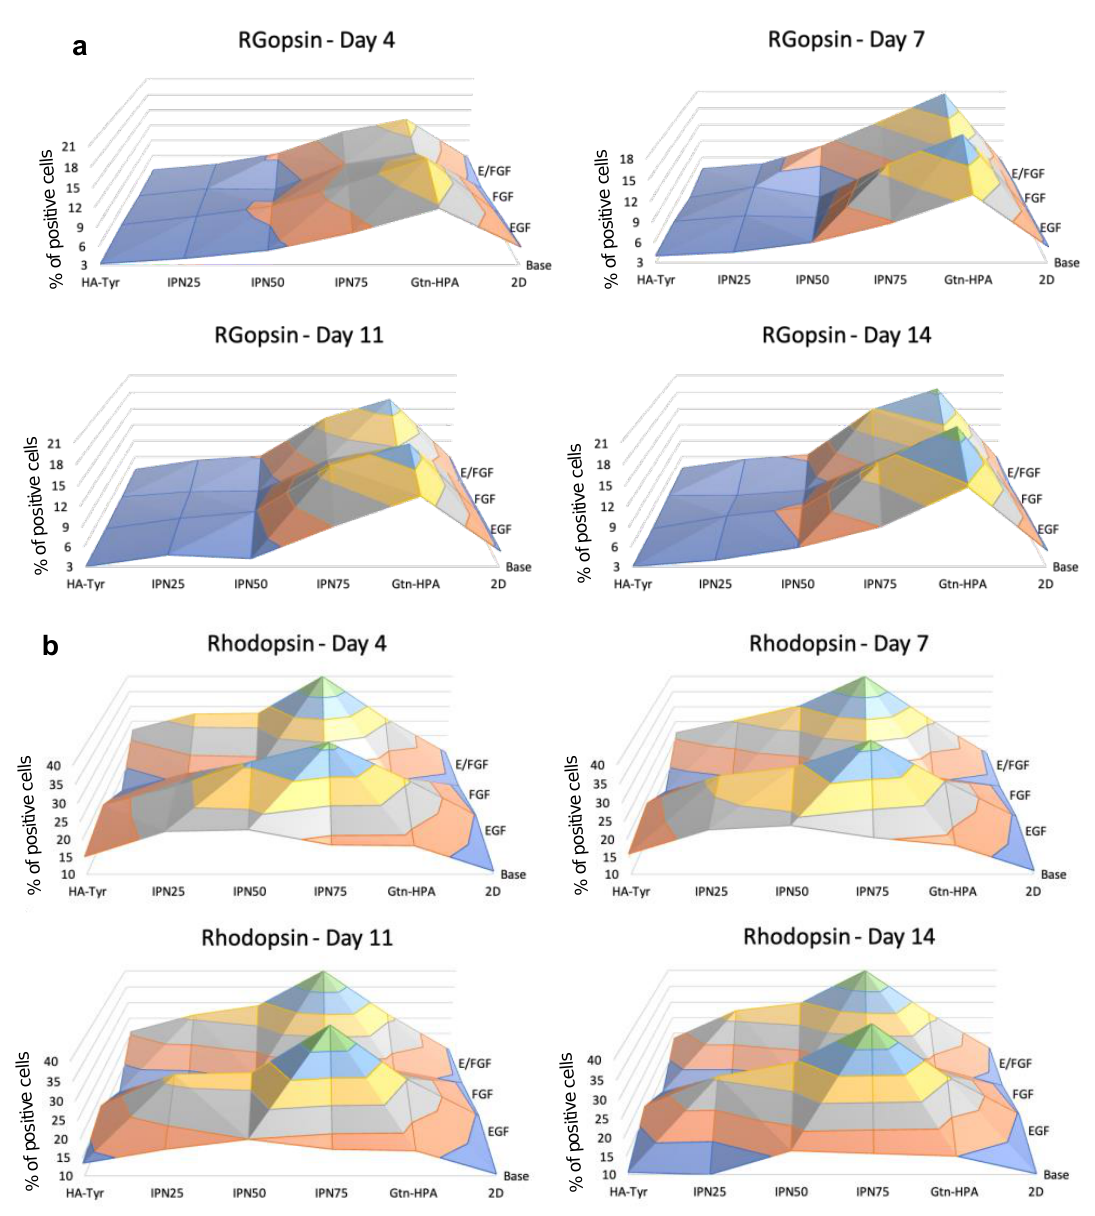
Figure 8. Phenotype assay for rod (rhodopsin) and cone (opsin) markers of hRPCs. Cells were cultured for 2 weeks and phenotype was analyzed at day 4, 7, 11, and 14 for n = 5 replicates with flow cytometry. Map surfaces show the medium component on the x -axis (base medium, EGF, FGF, or both), the tissue culture on the y -axis (2D, Gtn-HPA, IPN75, IPN50, IPN25, and HA-Tyr) and the expression of ( a ). R/G-opsin ( b ). Rhodopsin is shown on the z -axis. Cones show a specific peak for Gtn-HPA while rods show a peak for